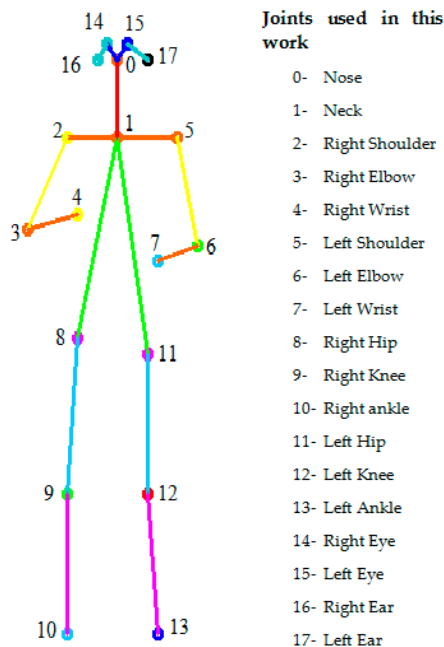
Figure 3. The human skeleton presentation used in our paper. This skeleton model presents 18 joints in which each joint is projected in the 2D plane. For the collection of human features, we used 36 values (18 × 2), for example, nose_x, nose_y, neck_x, neck_y, Right_shoulder_x, Right_shoulder_y, Right_elbow_x, Right_elbow_y, etc.